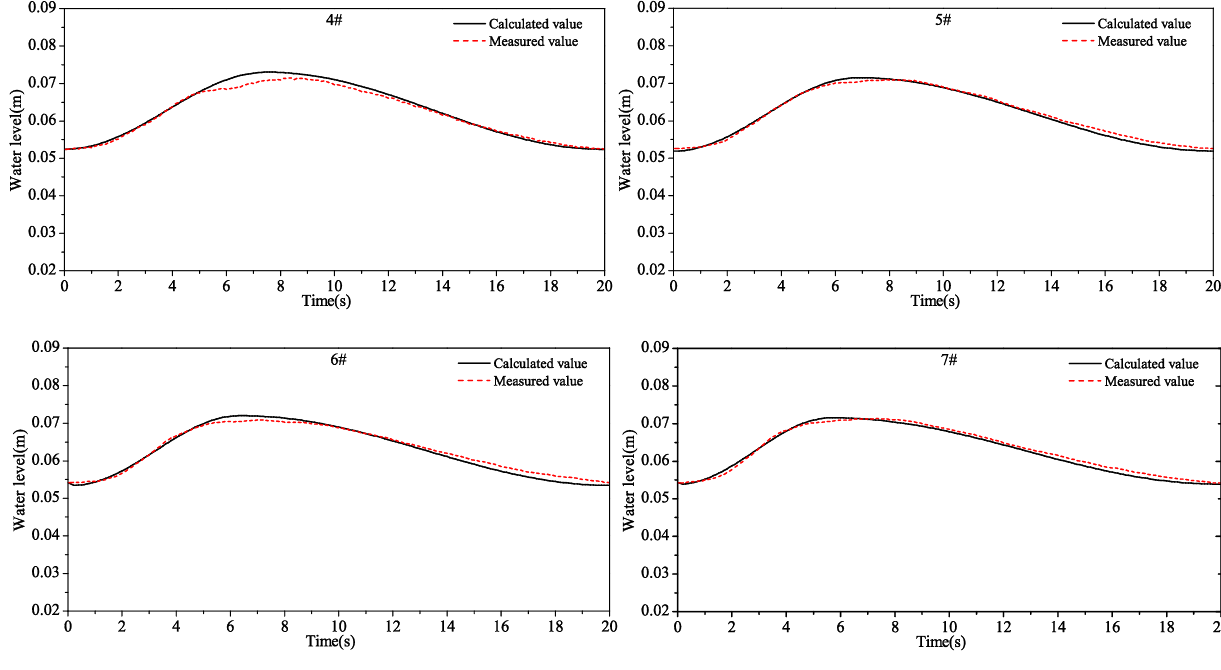
Fig. 8 Comparison of the water level at section Nos. 4–7: calculated vs. measured waveform Fig. 9 Verification of the calcu- lated flow rate and water level in